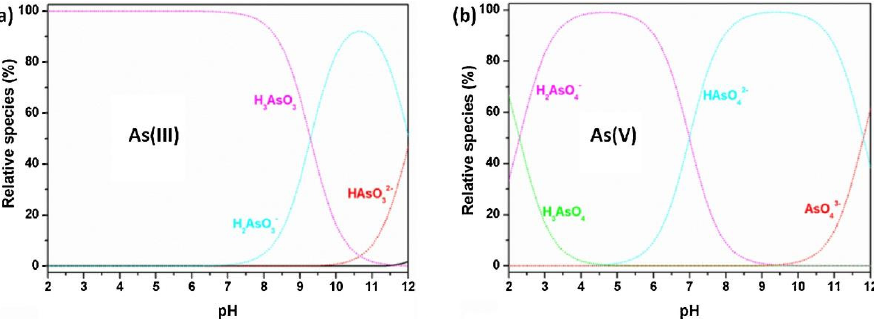
Figure 1. ( a ) As(III) and ( b ) As(V) speciation as a function of the solution pH [24].